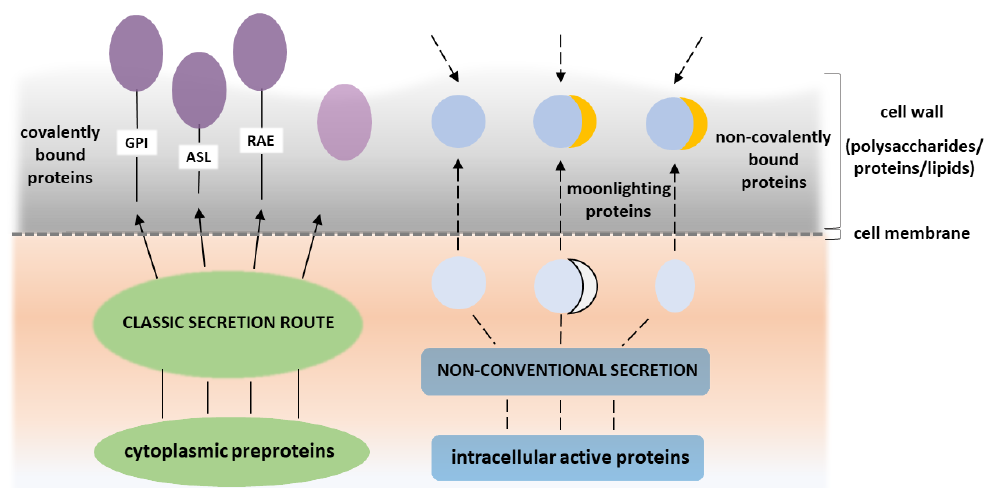
Figure 1. Major classes of proteins present at the C. albicans cell wall. Cytoplasmic preproteins that possess signal peptide pass the classical secretory route and emerge at the cell surface as “typical” cell wall proteins that are covalently anchored via three major linkages—GPI, ASL and RAE—but can also exist as loosely associated with the cell wall polysaccharide skeleton. In contrast, “atypical” proteins, despite the lack of a signal for the classical secretion pathway, appear at the cell wall due to an unconventional secretion or re-adsorption. Those that take on new functions at the cell surface are called moonlighting proteins.